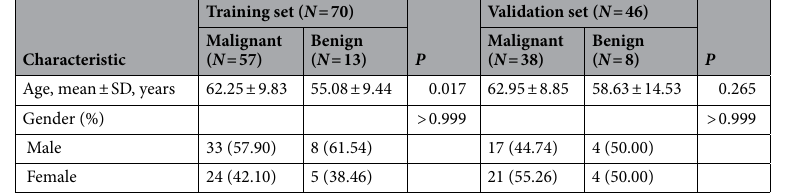
Table 1. Baseline characteristics of the training and validation